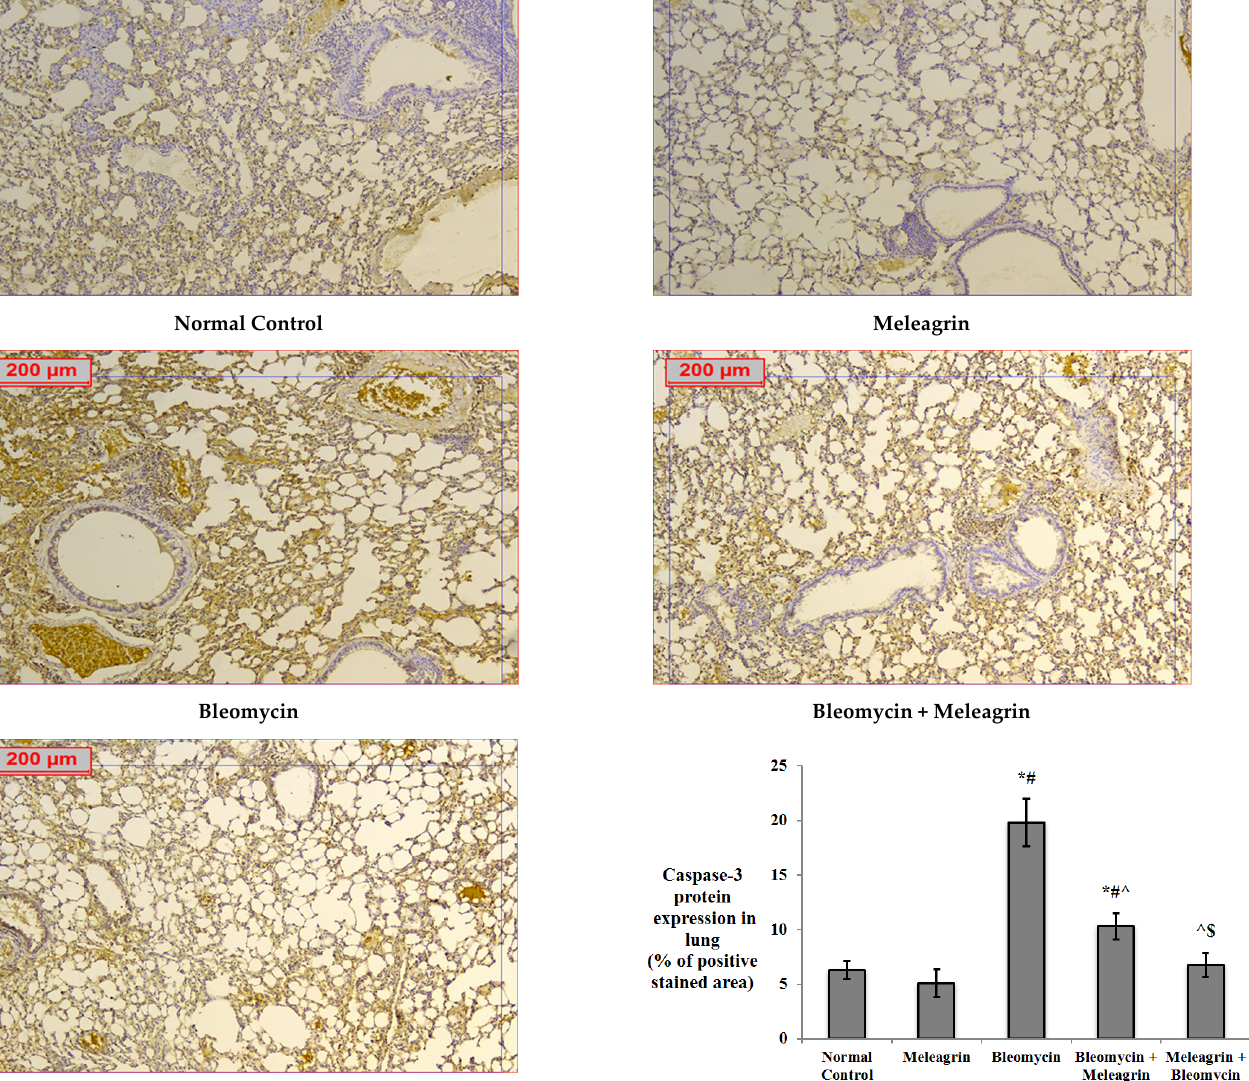
Figure 6. The effect of meleagrin on the protein expression levels of caspase-3 in the lung tissue of the experimental mice determined by immunohistochemistry. Data of the percentage of positive stained area are expressed as mean ± SD and analyzed using one-way ANOVA followed by Bonferroni’s post hoc test ( n = 8). * significantly different vs. the normal control group; # significantly different vs. the meleagrin group; ^ significantly different vs. the bleomycin group; $ significantly different vs. the bleomycin + meleagrin group. Differences were considered significant at p < 0.05.